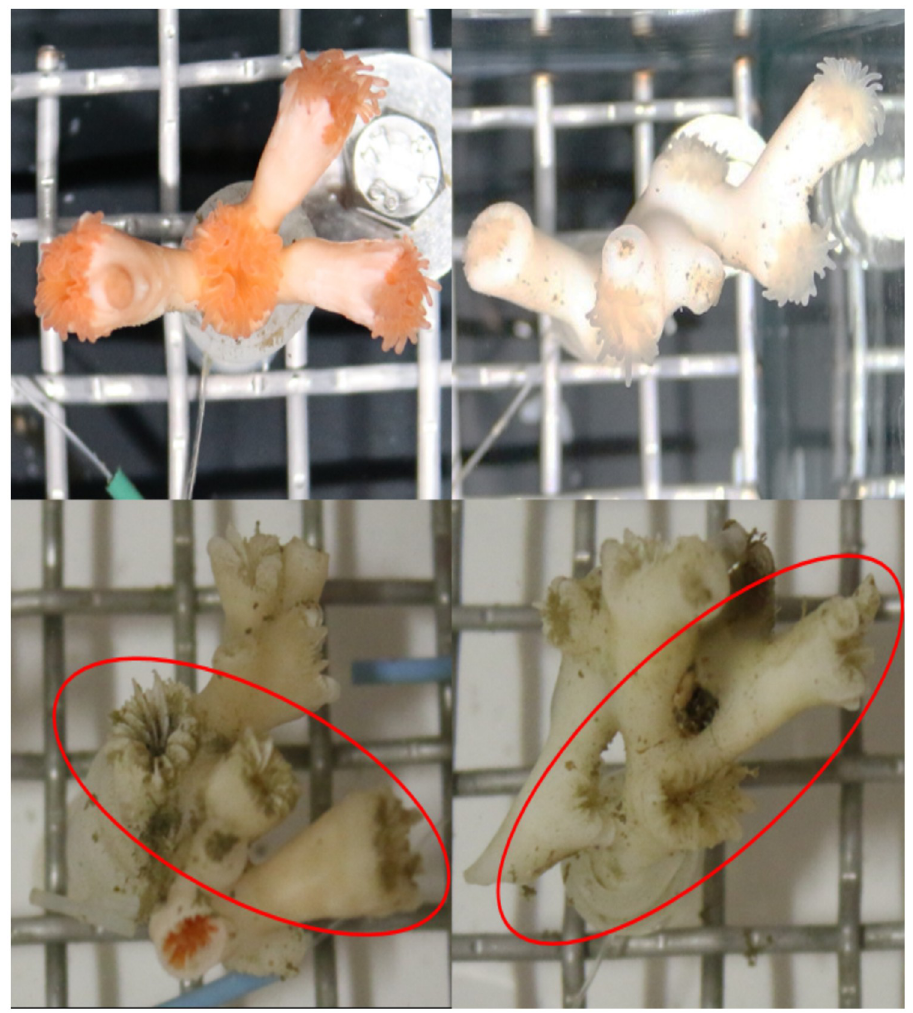
Fig 2. Example images of living and dead corals. Example images of alive and dead polyps. Upper row—pictures from time 0 h: orange and white coral samples with healthy polyps. Lower row—pictures from time 1440 h: orange and white coral samples with dead polyps (red ellipse indicates dead polyps). The coral sample in the lower left picture was orange prior to exposure, but exposure to 2-methylnaphthalene lead to loss of pigmented tissue and has rendered it predominantly white. The lower right picture exhibits a white coral sample with dead